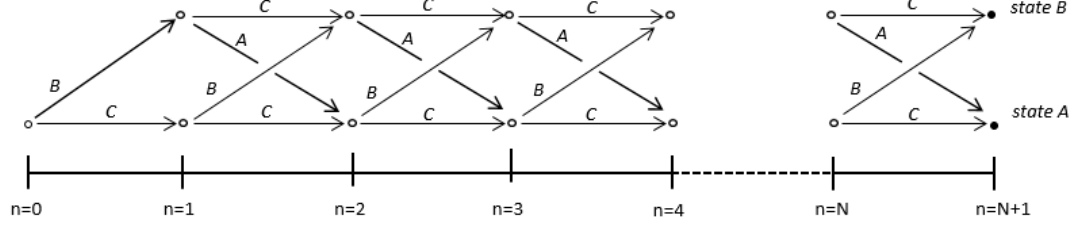
Figure 2. The concept of the output switching option (source: own study).